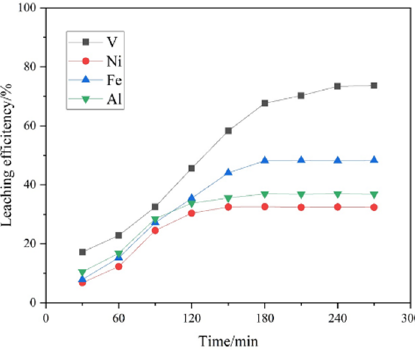
Figure 5. Effects of leaching time on leaching efficiency of metals (C C2H2O4 = 2 mol/L; T = 95 °C; D50 ≤ 17.34 µ m).